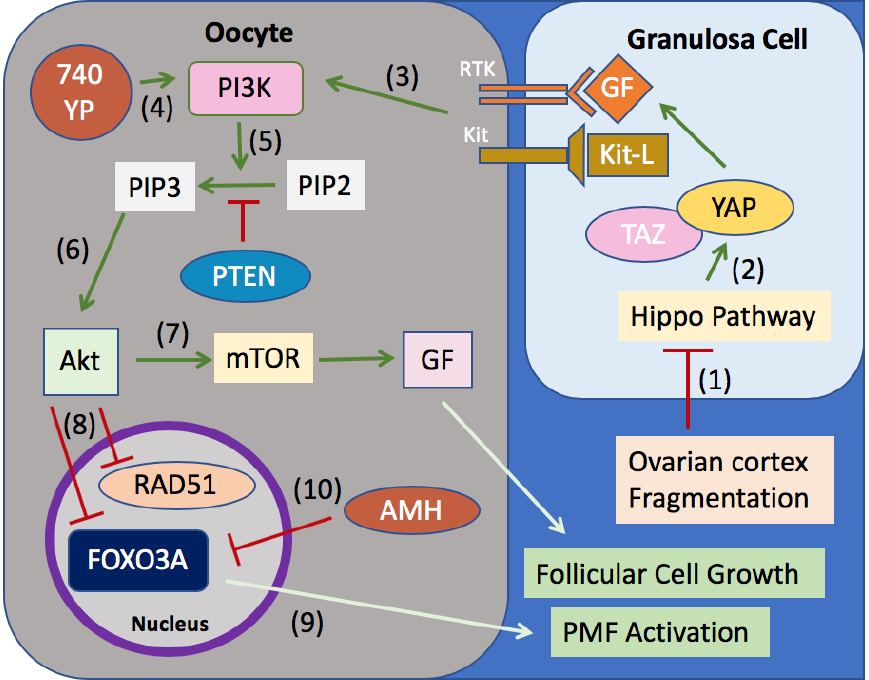
Figure 2. Selected pathways relevant for plausible salvaging of residual ovarian function in primary ovarian insufficiency. (1) Ovarian cortex fragmentation disrupts the Hippo signaling pathway leading to dephosphorylation of YAP and TAZ, which (2) stimulates transcription of growth factors (GFs), including GDF9 and BMP15 (transforming growth factor-beta family). (3) GF and Kit-ligand (Kit-L) as well as (4) 740YP administration increase PI3K activity, whereas PTEN serves to keep follicles dormant. (5) Activation of the PI3K complex activates PIP2 to PIP3, which (6) leads to increased Akt expression. (7) Phosphorylated Akt upregulates mTOR, leading to downstream GF transcription, and (8) inhibits activation of RAD51 and FOXO3A. (9) This prevents nuclear export of FOXO3A, decreasing primordial follicle activation. Similarly, (10) anti-Müllerian hormone (AMH) decreases activation of phosphorylation of FOXO3A. Green arrows represent activation steps, and red bar-headed lines represent inhibition. AKT, protein kinase B; FOXO3, forkhead box O3; mTOR, mammalian target of rapamycin; PI3K, phosphatidylinositol-3-kinase; PIP2, phosphatidylinositol-4,5-bisphosphate; PIP3, phosphatidylinositol-3,4,5-bisphosphate; PMF, primordial follicle; PTEN, phosphatase and tensin homolog deleted on chromosome 10; TAZ, transcriptional coactivator with PDZ-binding motif; YAP, Yes-associated